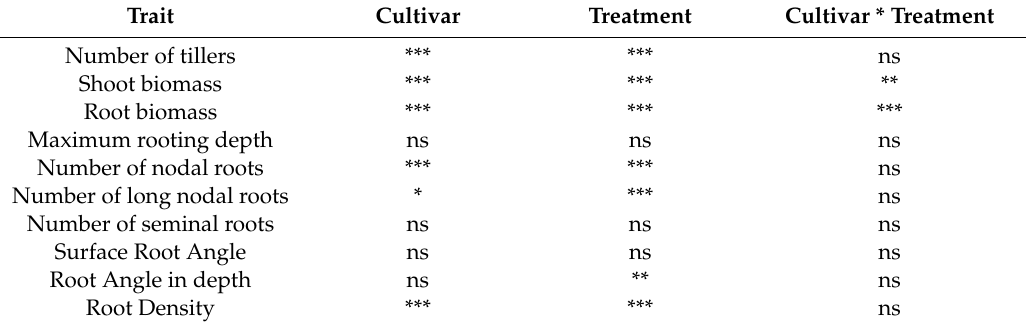
Table 2. E ff ect of cultivar, treatment and the combination of both factors in the studied shoot and root traits. The first column lists the specific shoot and root traits quantified in the experiment. Second to fourth columns show the e ff ect of cultivar type (i.e., Duster or Cheyenne), treatment (i.e., no leaf clipping, 40% leaf clipping or 100% leaf clipping) and the combination of both in the quantified traits showed in the first column. Significant di ff erences of the means were determined by using two-way ANOVA. Asterisks represent distinct means within groups at p < 0.05 (*); p < 0.01 (**); p < 0.001 (***) and no significant e ff ect